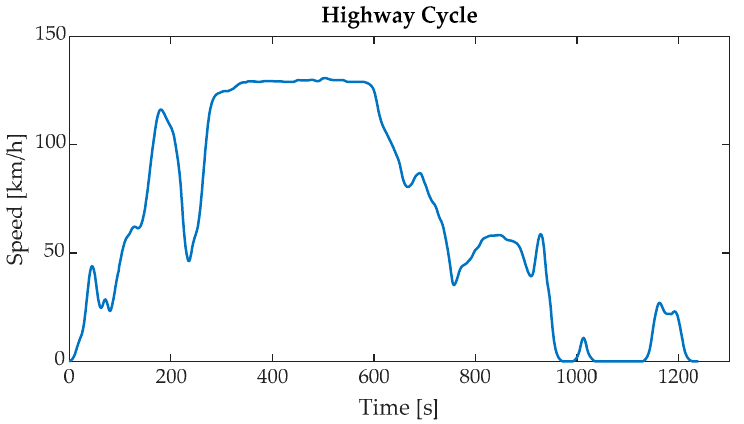
Figure 4. Speed profile and net road altitude variation of the uphill real ‐ world drive mission.